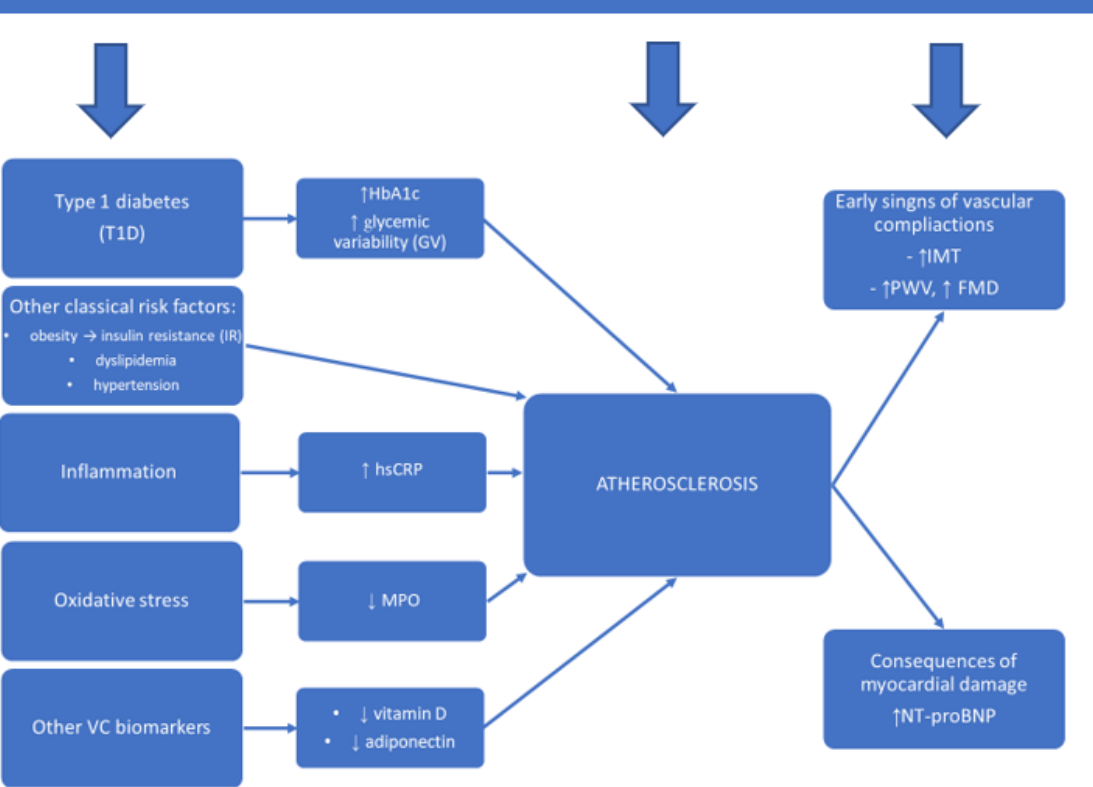
Figure 5. Proposed pathophysiological impact of classical risk factors and new biomarkers on the progression of atherosclerosis and possible ways to influence the process of diminishing vascular disease development.